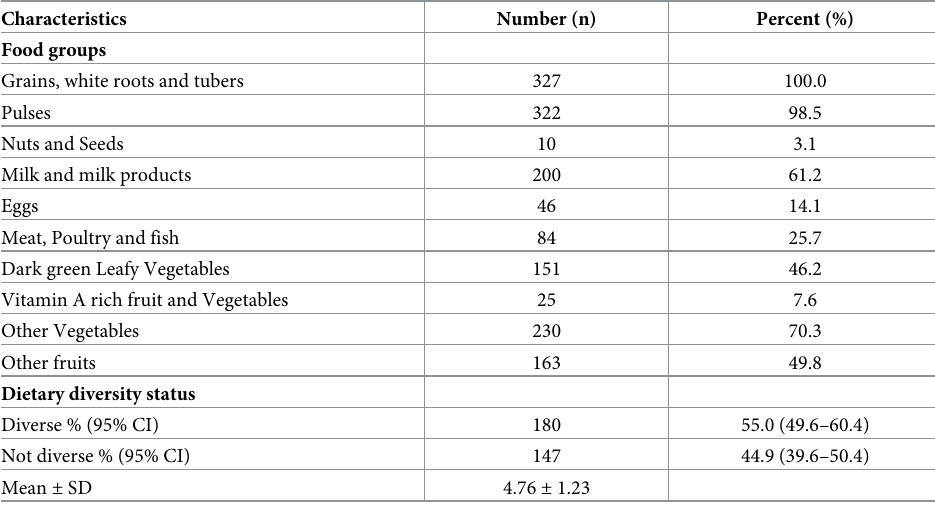
Table 2. Dietary diversity and individual food group consumption by